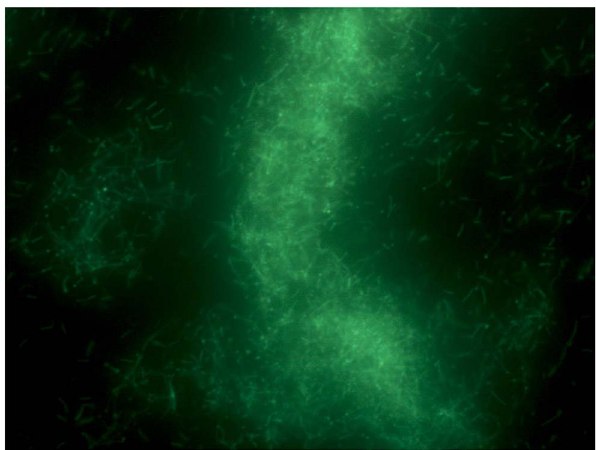
Figure 3. Bcell growth on A.niger mycelia. Microscopic images (2000 6 magnification) of Bcell culture growing on A. niger mycelia; same field with dark field epifluorescence.